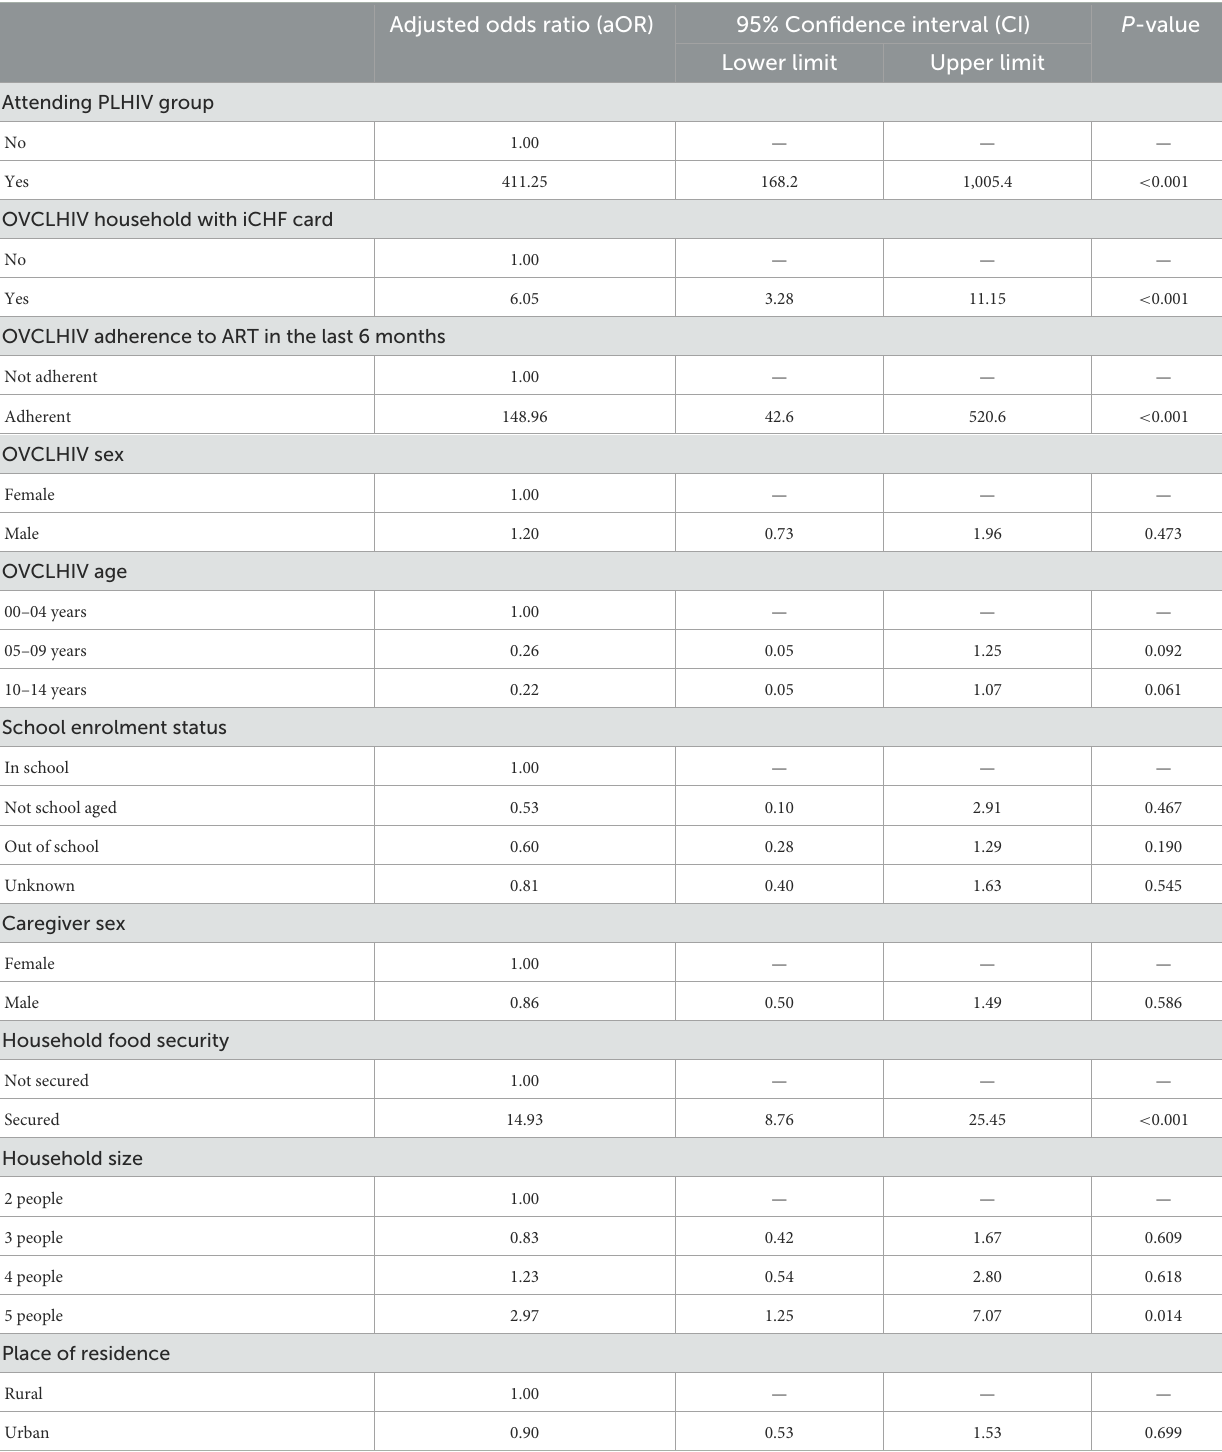
TABLE 3 Multivariable logistic regression analysis of factors associated with viral suppression at 24 months among OVCLHIV on ART in Tanzania ( N =